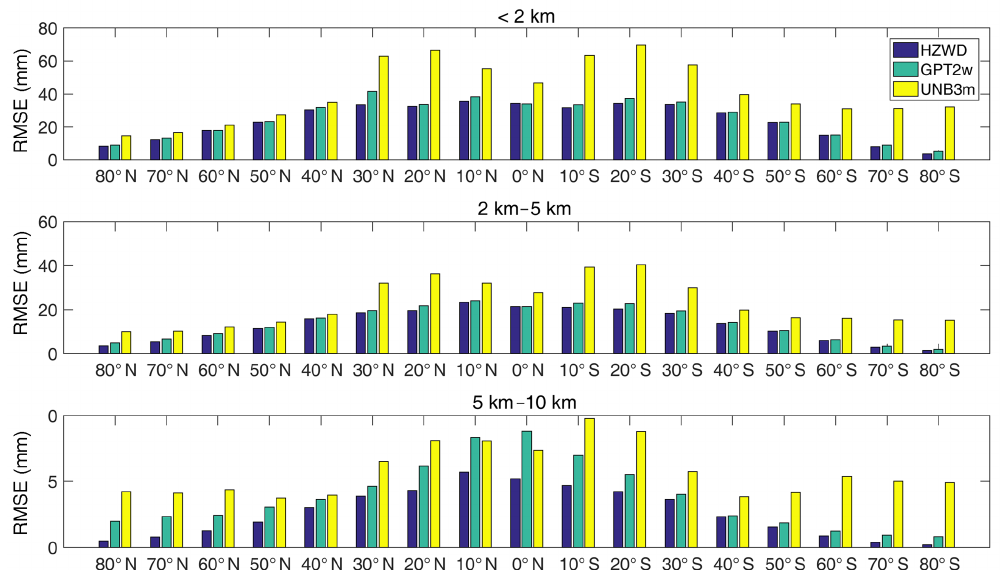
Figure 9. RMSE comparisons between the three models (HZWD, GPT2w, and UNB3m) in different latitude bands over the year